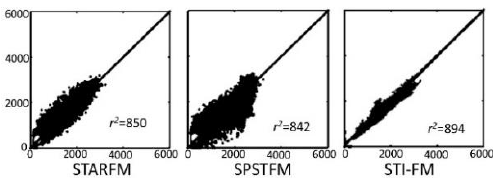
Figure 2. Synthetic Landsat-7 images and the actual Landsat-7 image for the CIA site on 11 January 2002. ( a – c ) are the synthetic images of STARFM, SPSTFM, and STI-FM, respectively; ( d ) actual Landsat-7 image. The SWIR1, NIR, and Red bands are used to generate the figures.